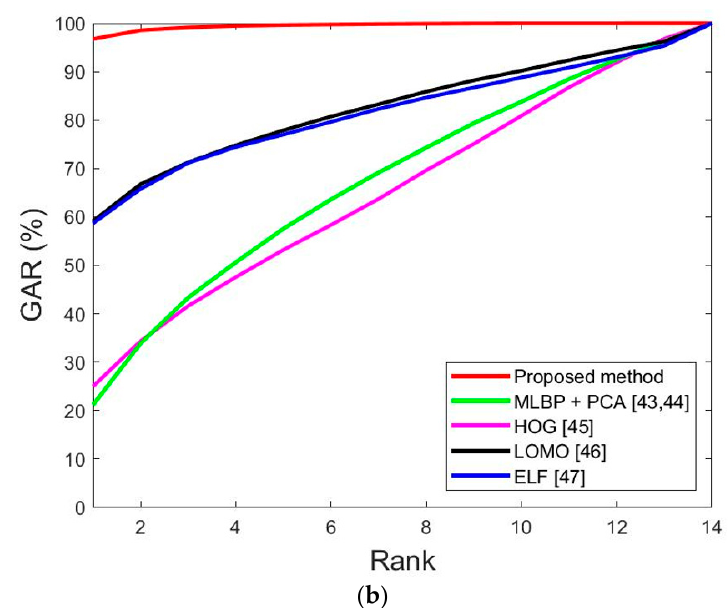
Figure 17. CMC curves for the proposed and previous method on ChokePoint dataset. ( a ) Face image recognition results via the proposed and previous methods; ( b ) face and body image recognition results for the proposed and previous methods.